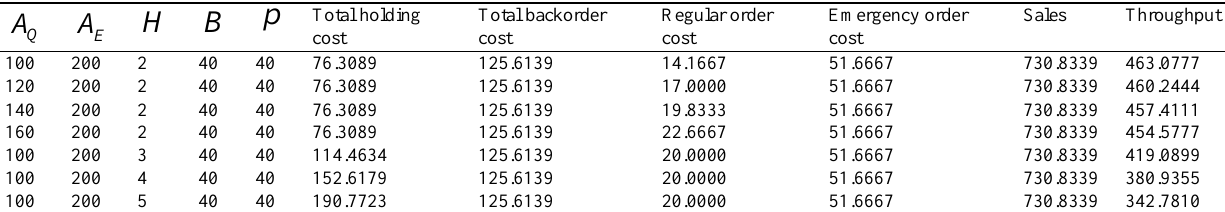
Table 3 Performance of TOC3 control policy